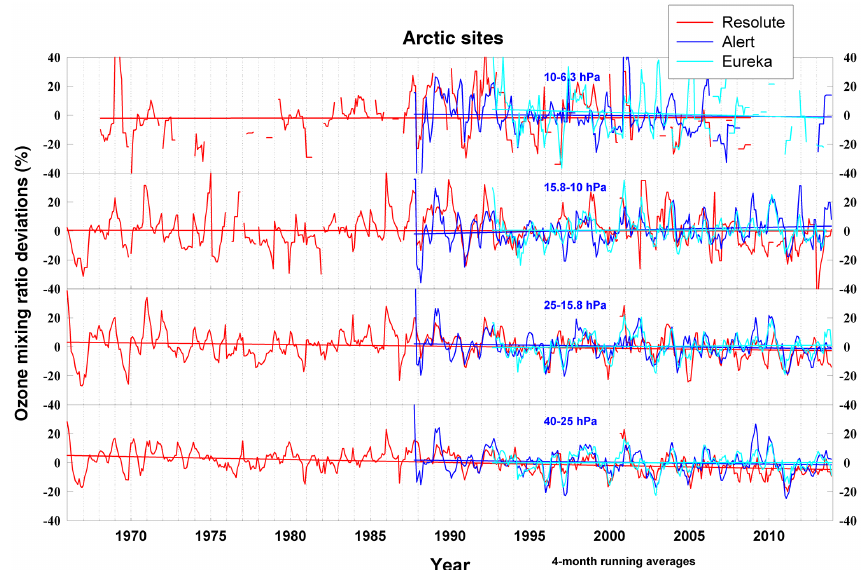
Figure 14. As Fig. 13, for the three Arctic stations. The overall station trend lines are